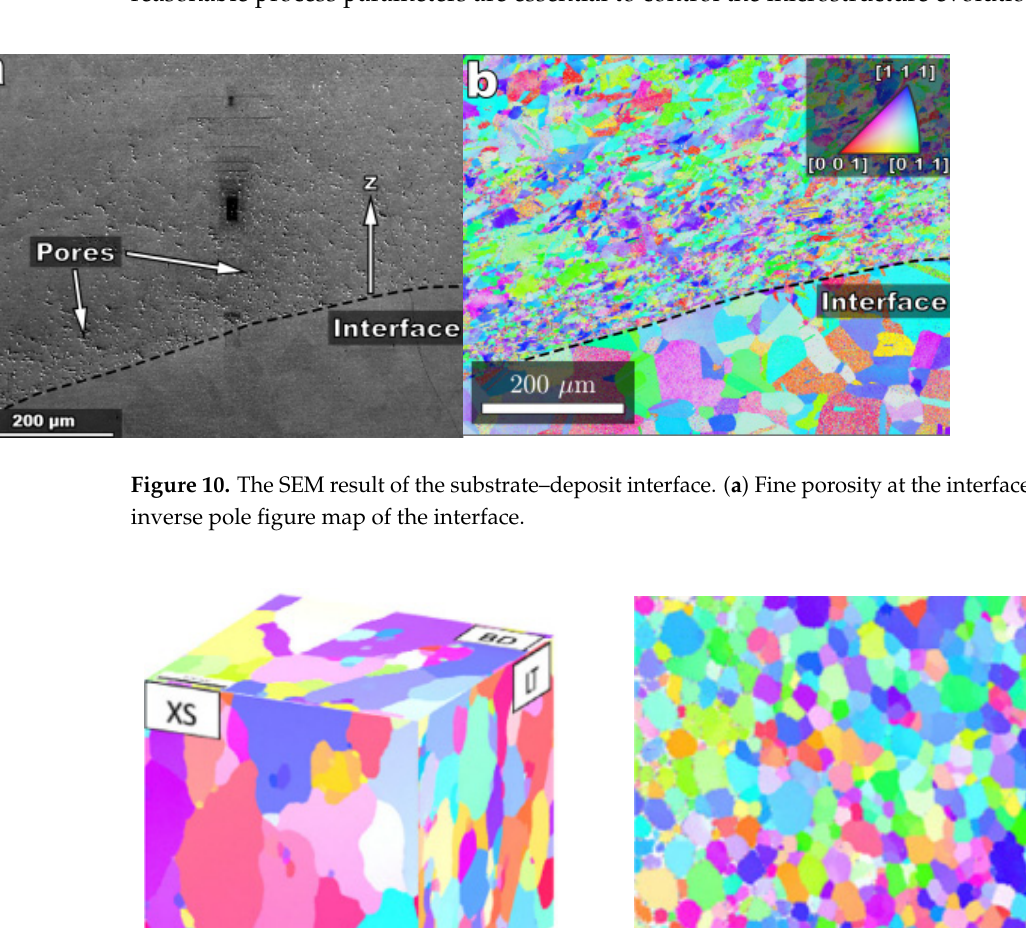
Figure 10. The SEM result of the substrate–deposit interface. ( a ) Fine porosity at the interface. ( b ) The inverse pole figure map of the interface.